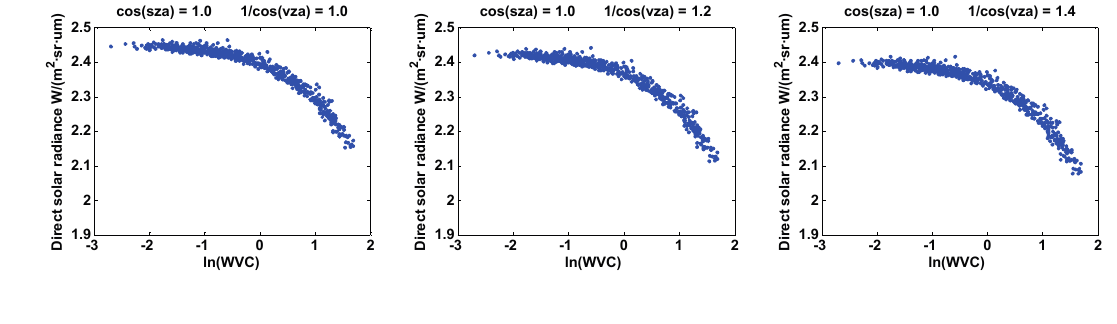
Figure 1. Relationships between direct solar radiance ( D i ) and ln( WVC ). ( a ) AHS CH66 (SZA = 0°, VZA = 0~60°). ( b ) AHS CH68 (SZA = 0°, VZA = 0~60°). ( c ) AHS CH66 (VZA = 0°, SZA = 0~60°). ( d ) AHS CH68 (VZA = 0°, SZA =